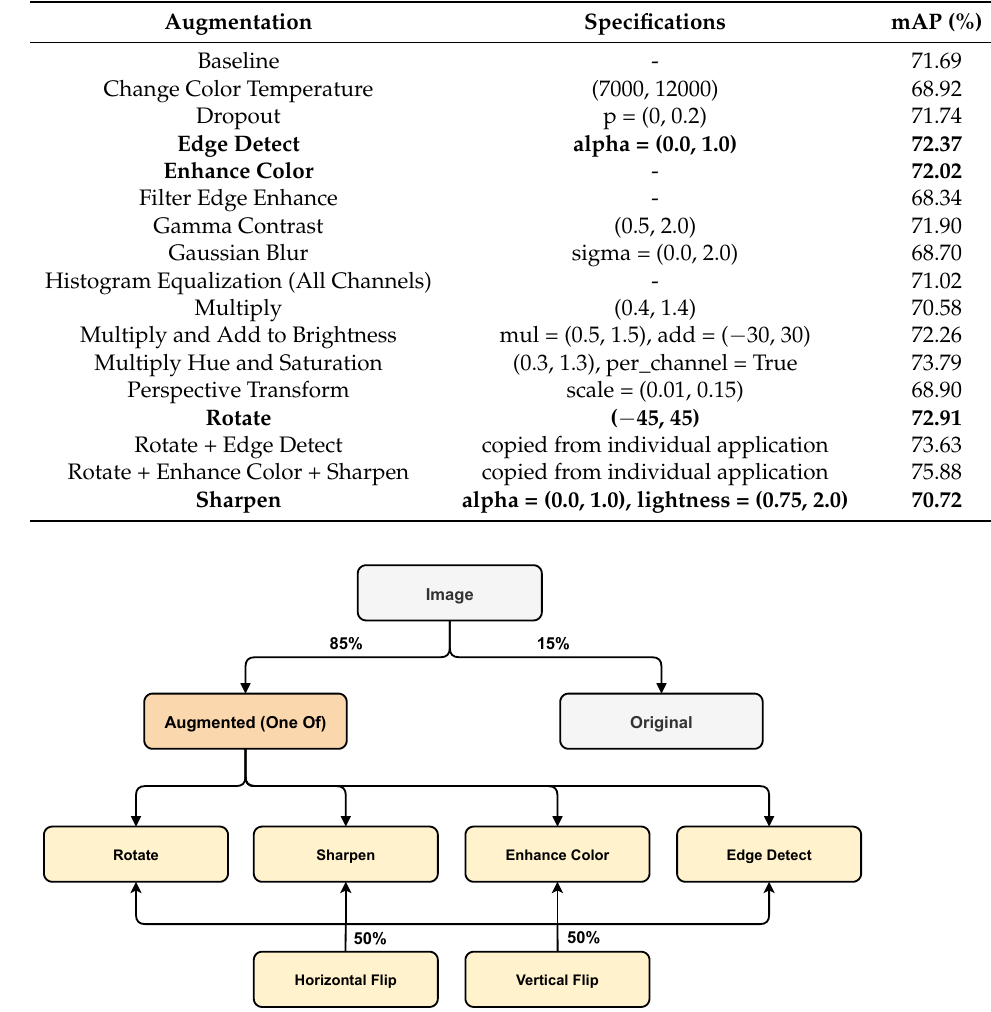
Table 6. Details of the various augmentation techniques tested on our dataset.